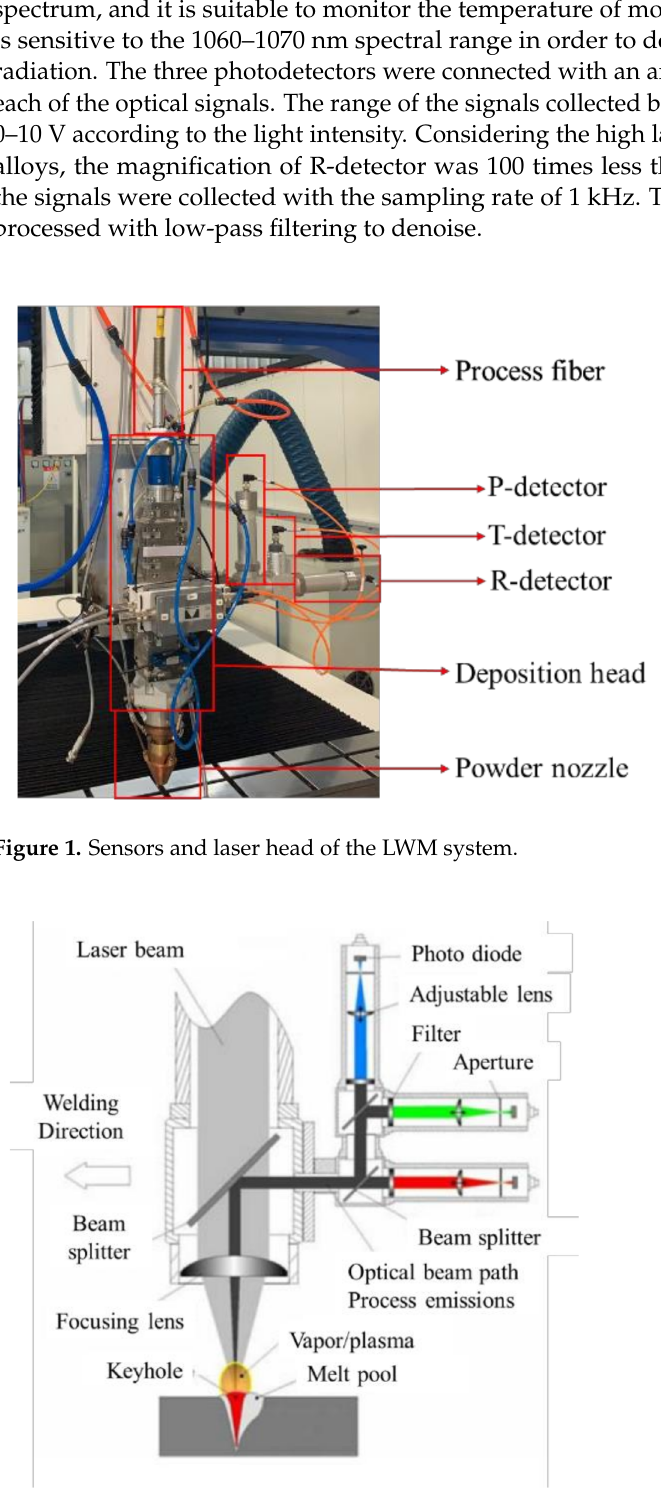
Figure 2. Principle diagram of the LWM system